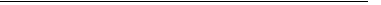
→ e ± N e → e ± e ± jj processes (dashed lines) and the R → W ∓∗ δ ±±∗ → e ± e ± jj processes (solid lines) at the 14 TeV R R R